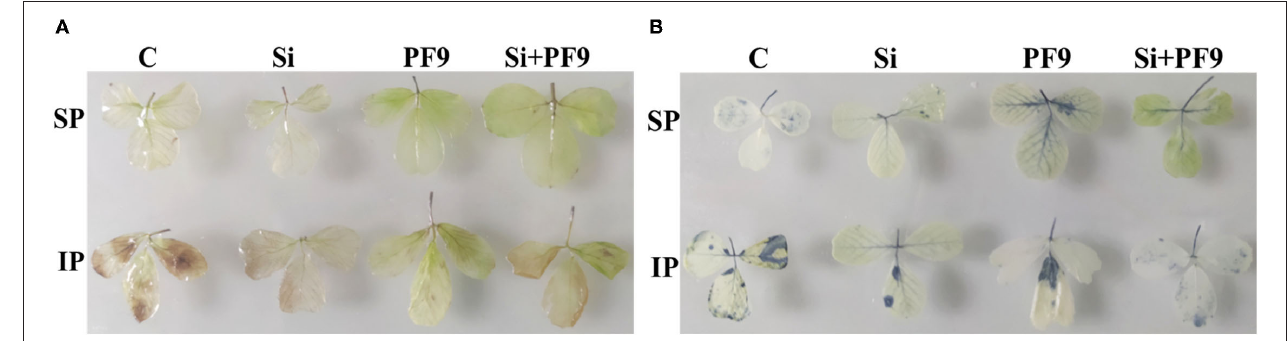
FIGURE 3 | Effect of 3mM Si treatment and PF9 strain inoculation on hydrogen peroxide (H 2 O 2 ) (A) and peroxide (O − 2 ) (B) accumulation in the leaves of Medicago sativa ( OL population) plants grown under 250 µ mol of either soluble (KH 2 PO 4 ) (SP) or insoluble (Ca 3 HPO 4 ) (IP) phosphorus conditions. H 2 O 2 and O − 2 accumulation in the leaves were detected using 3,3 ′ -diaminobenzidine and nitroblue tetrazolium methods, respectively.